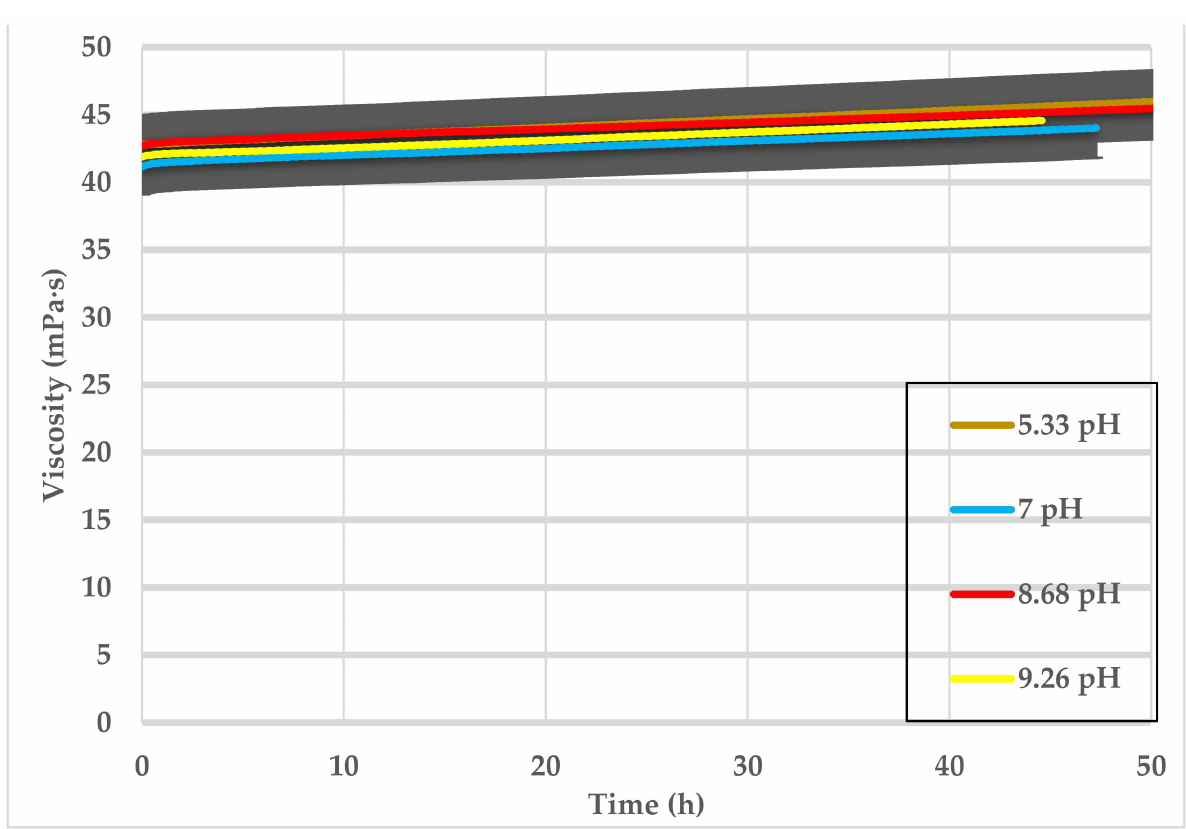
Figure 7. SW based viscosity versus time, 0.5 wt% CMHPG polymer mixed with low pH values of GLDA <